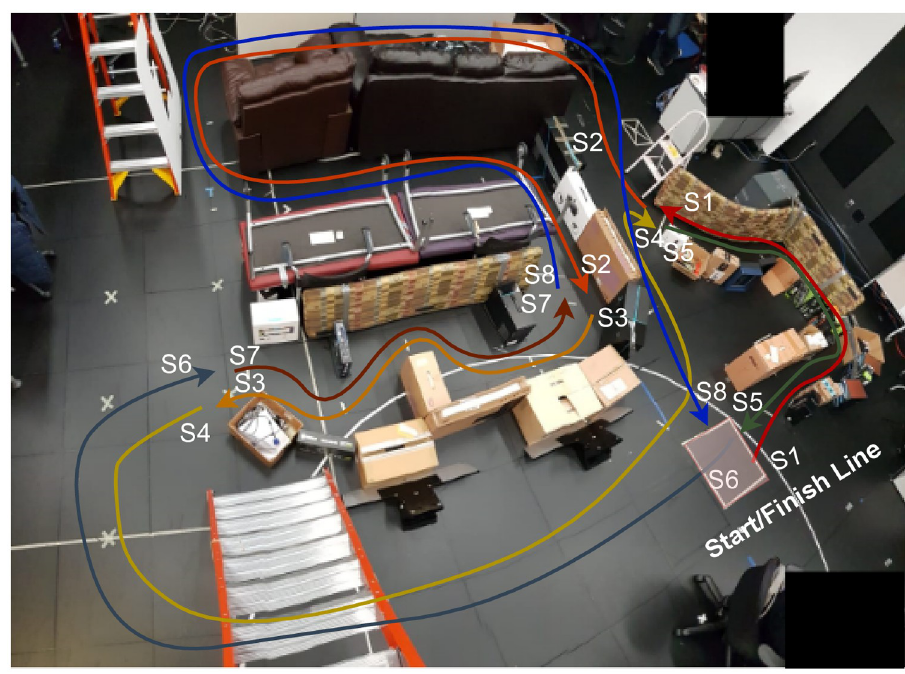
Fig 4. Real world view of the obstacle course. This photo was taken from top of the ladder as a panoramic picture. Distortions in the picture caused by the panoramic stitching.